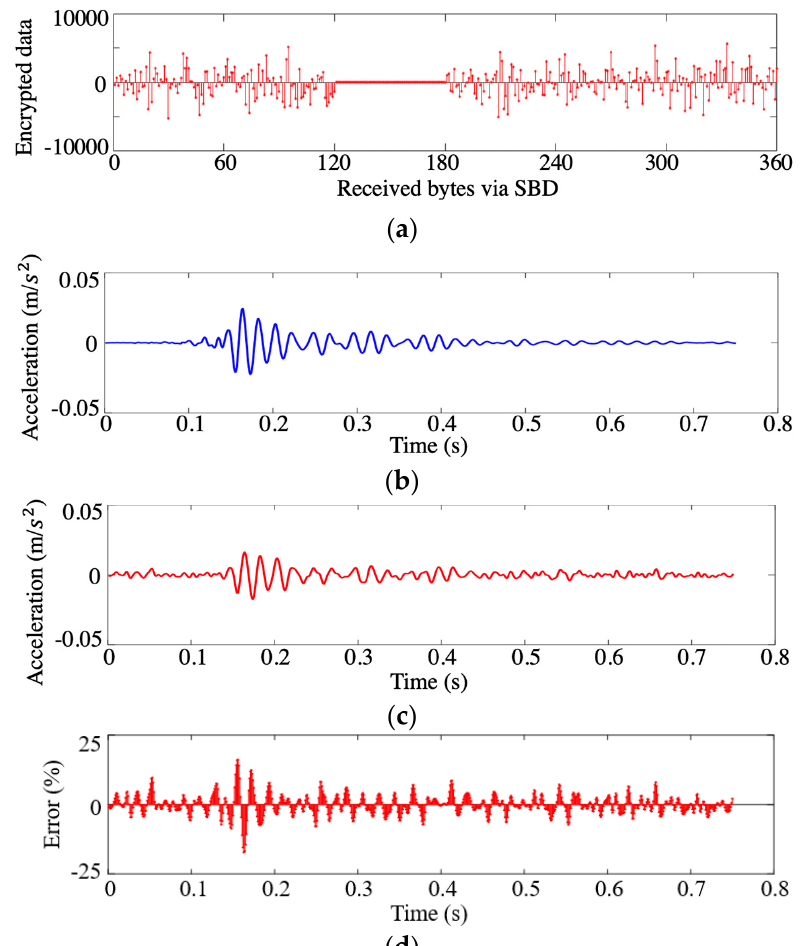
Figure 6. Recovered results of sensor 5 from SBD data loss: ( a ) Received data packets with 16.7% data loss; ( b ) original acceleration extracted from backup file; ( c ) recovered data from the remaining SBD data packets; and ( d ) comparison and reconstruction error.